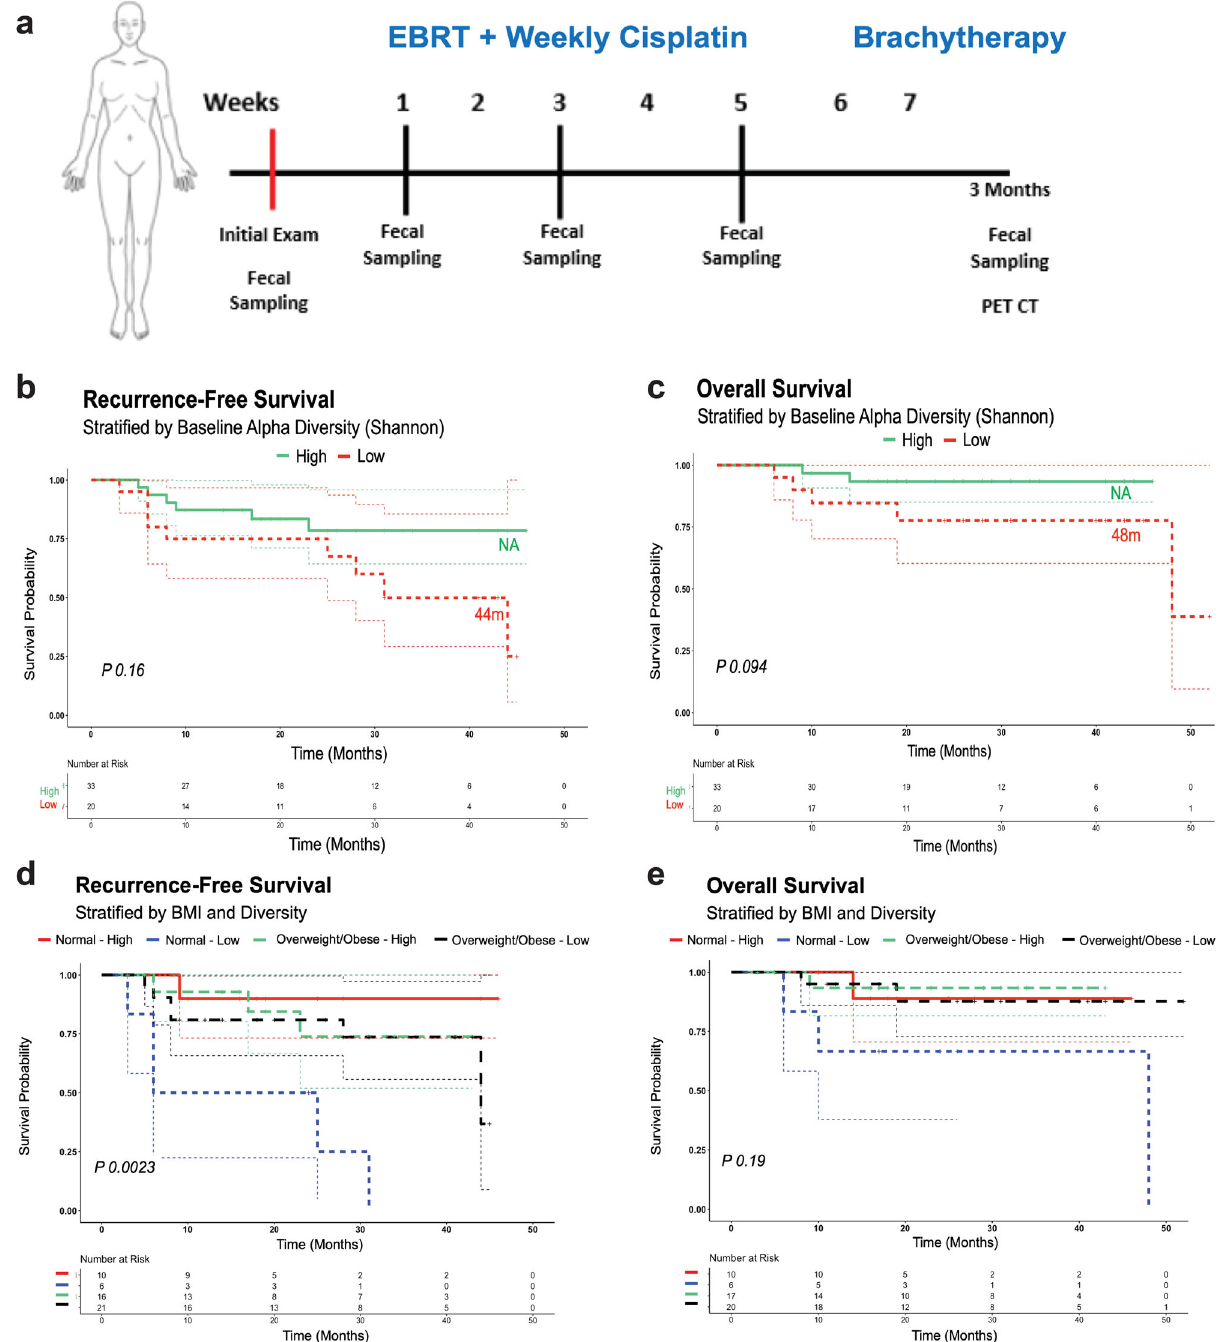
Fig. 1 Relationship between gut diversity and BMI. a Schema of the sample collection, treatment, and analyses used in the present study. Kaplan – Meier curves for b recurrence-free survival, c overall survival strati fi ed by high and low gut diversity (SDI). Kaplan – Meier curves for d recurrence-free survival, e overall survival strati fi ed by BMI and gut diversity. Cases represent patients. Only baseline samples were used for this analysis. BMI cutoffs were based on WHO standards (underweight < 18.5, normal 18.50 – 24.99, overweight ≥ 25, obese ≥